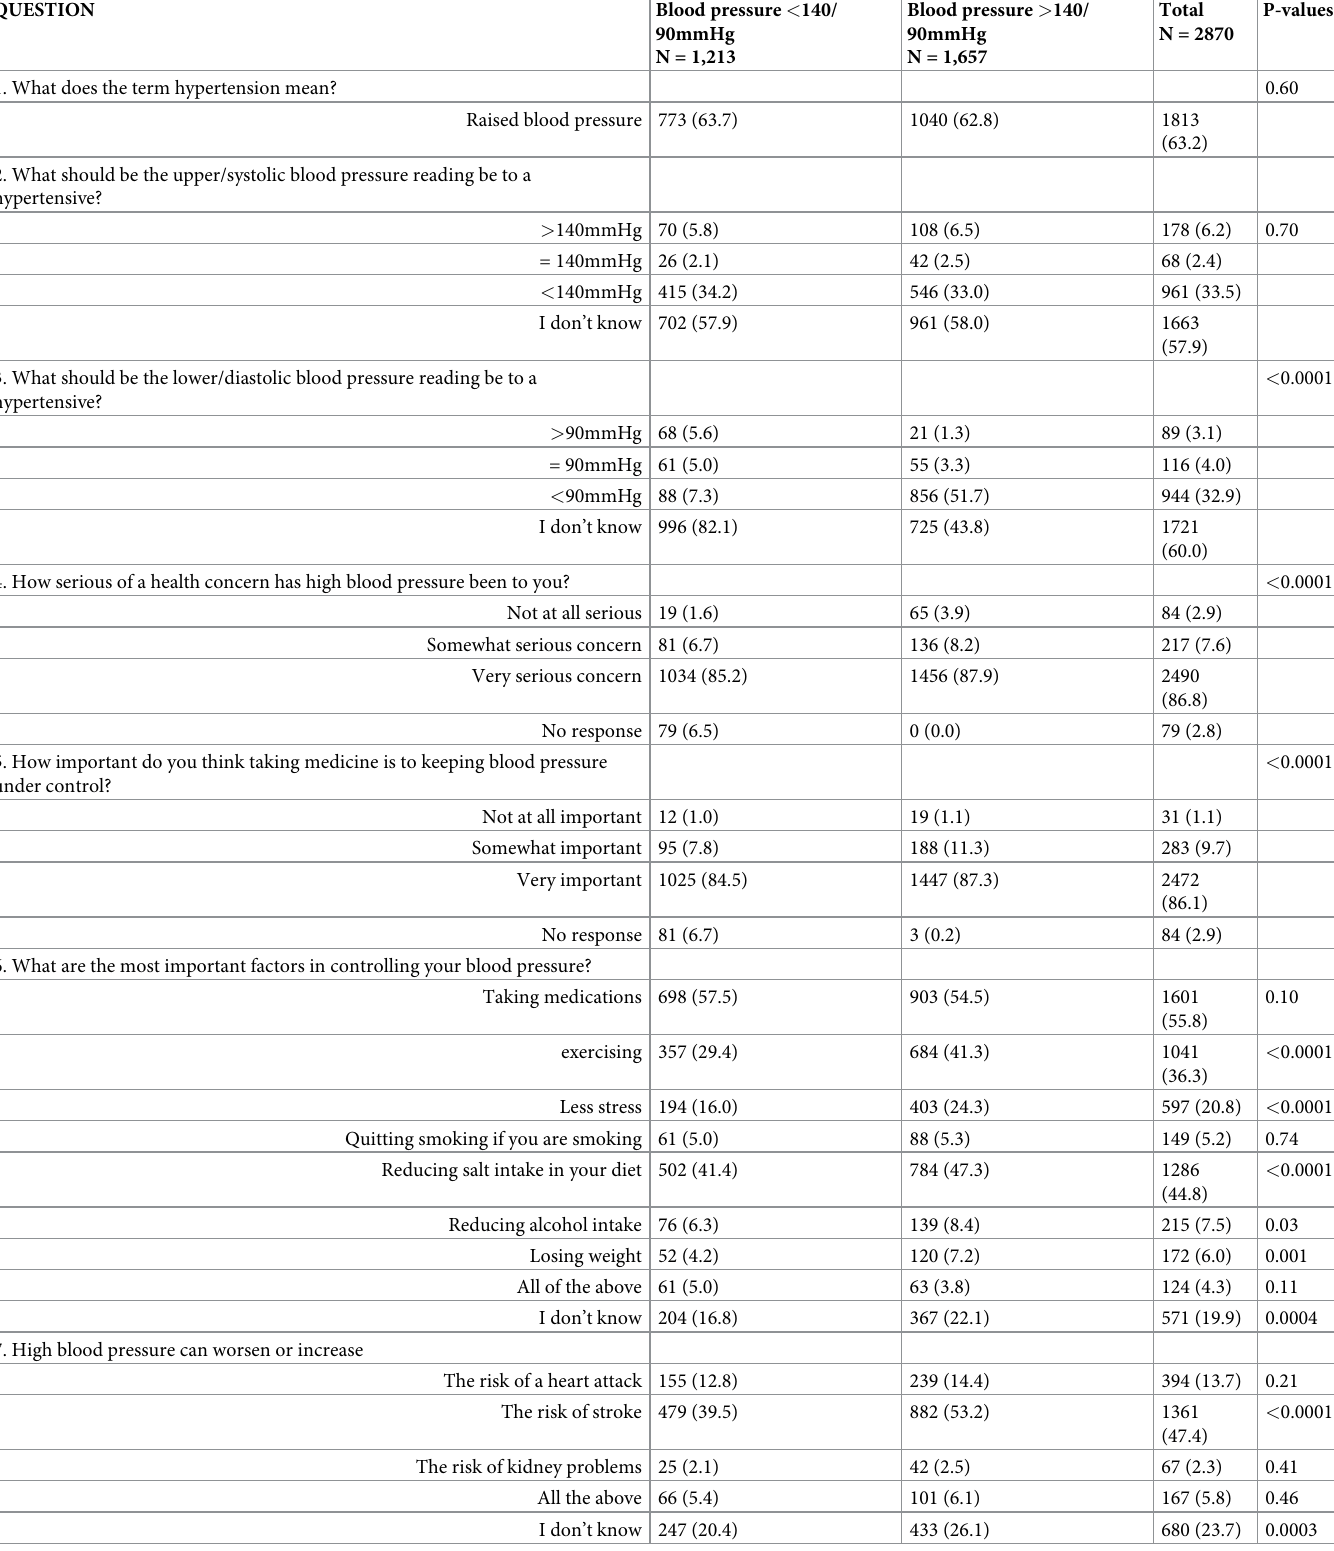
Table 3. Knowledge, attitudes & practices of patients on hypertension according to BP control